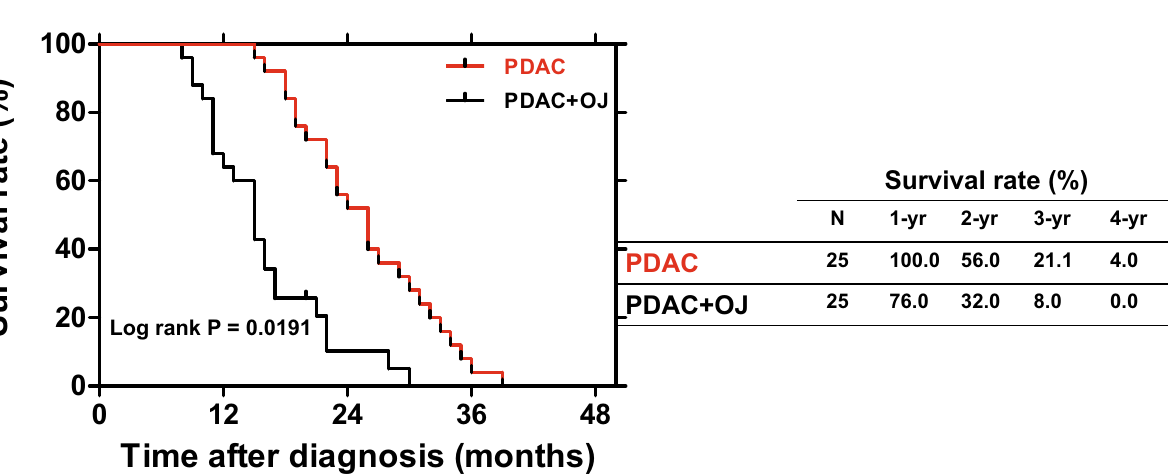
Figure 6. Survival curves of PDAC patients. The 4-year overall survival rate was significantly poorer in the PDAC + OJ group than in the PDAC group (log rank p = 0.0191). PDAC pancreatic ductal adenocarcinoma, OJ obstructive